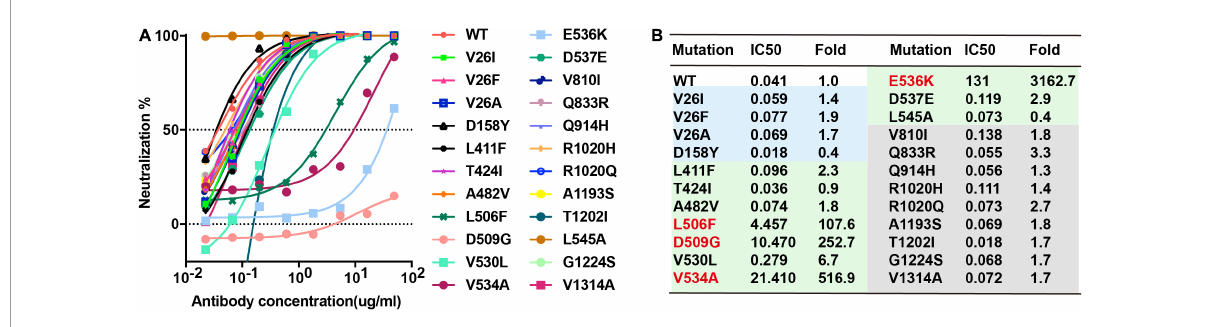
FIGURE4 Breadth of MERS-S41 neutralization. (A) Neutralizing analysis of MERS-S41 IgG against MERS-CoV wild-type (WT) and its variant mutants. Site-directed mutations were introduced into the EMC strain to create 23 variant mutants according to natural mutations of MERS-CoV S. (B) Summary of MERS-S41 IgG mediated inhibition of infection by all pseudotyped viruses. IC 50 neutralization titers for mutant EMC S variants are presented relative to wild-type S.